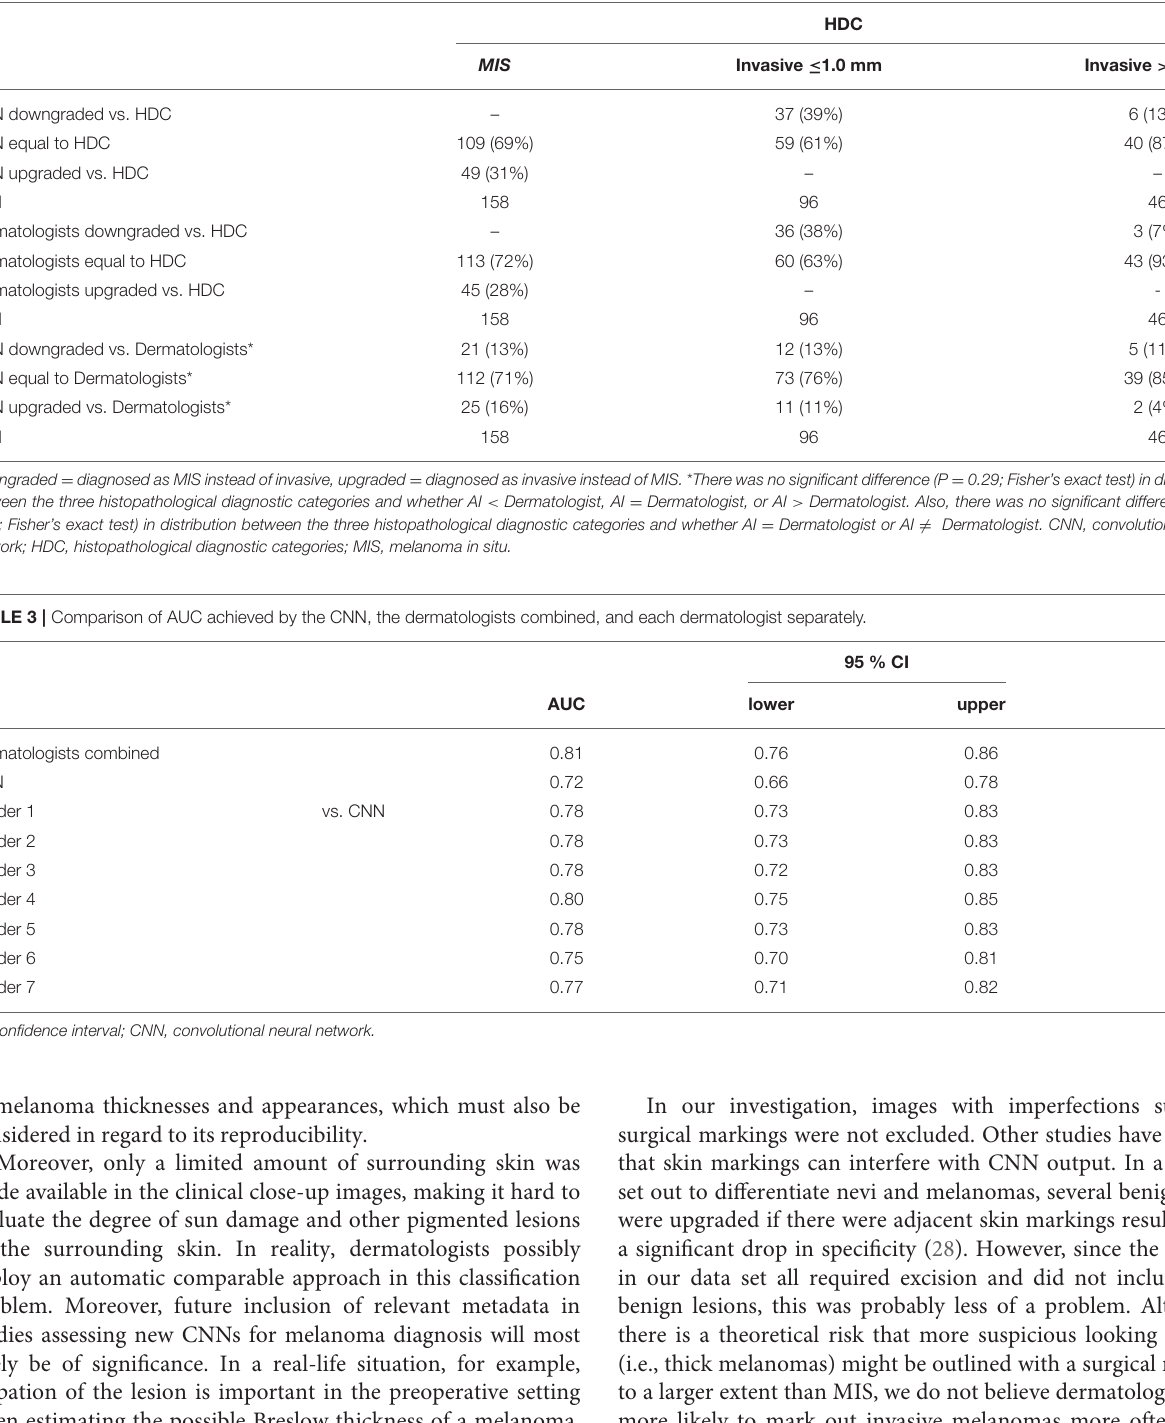
TABLE 2 | Breakdown of incorrectly upgraded and downgraded lesions.